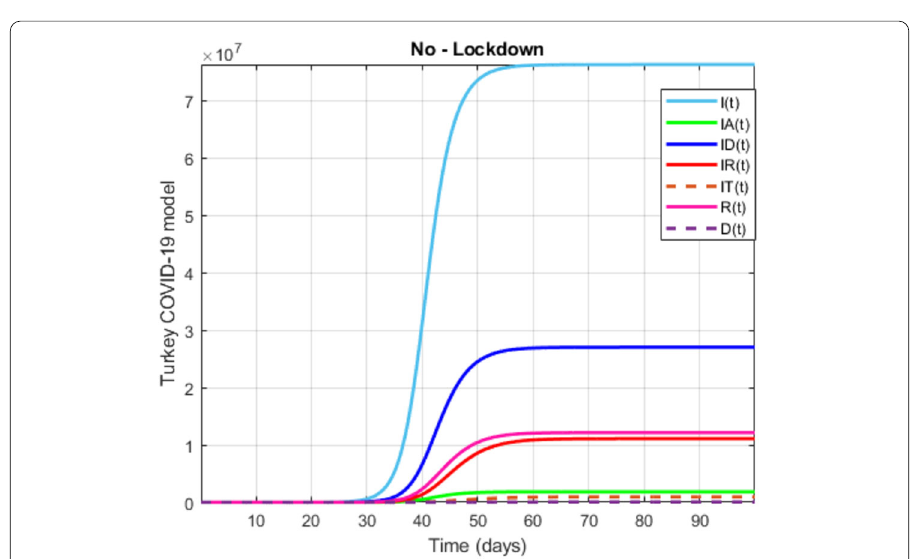
Figure 35 Numerical visualization for Covid-19 model in Turkey